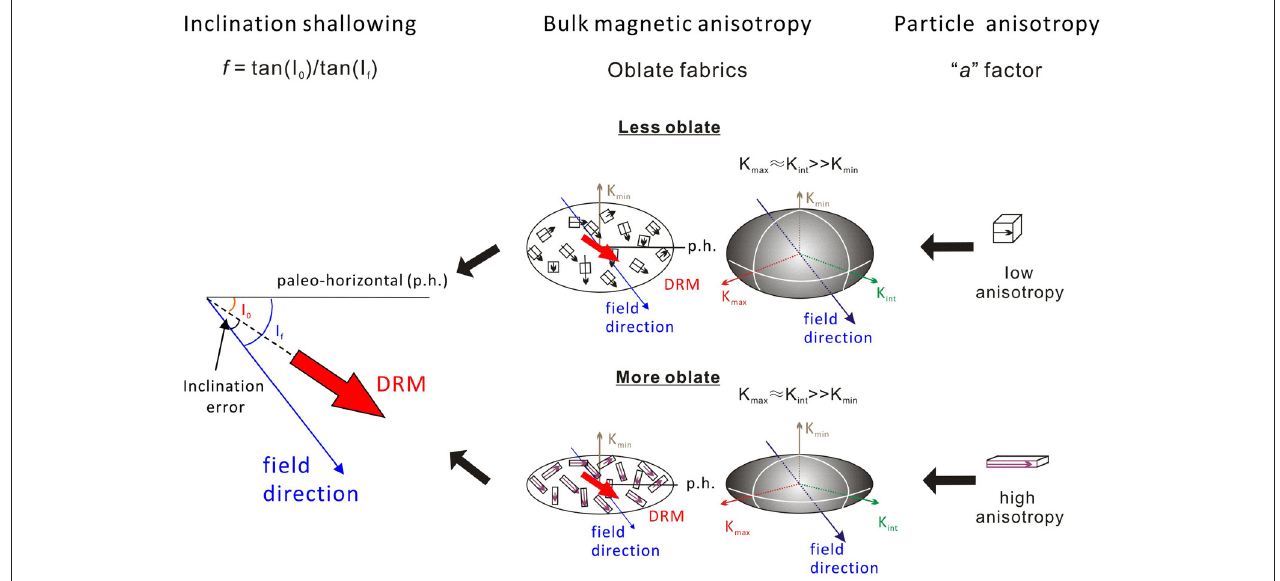
FIGURE 1 | Schematic diagram that indicates how inclination shallowing is a function of both bulk anisotropy and individual particle anisotropy “ a ” factor.